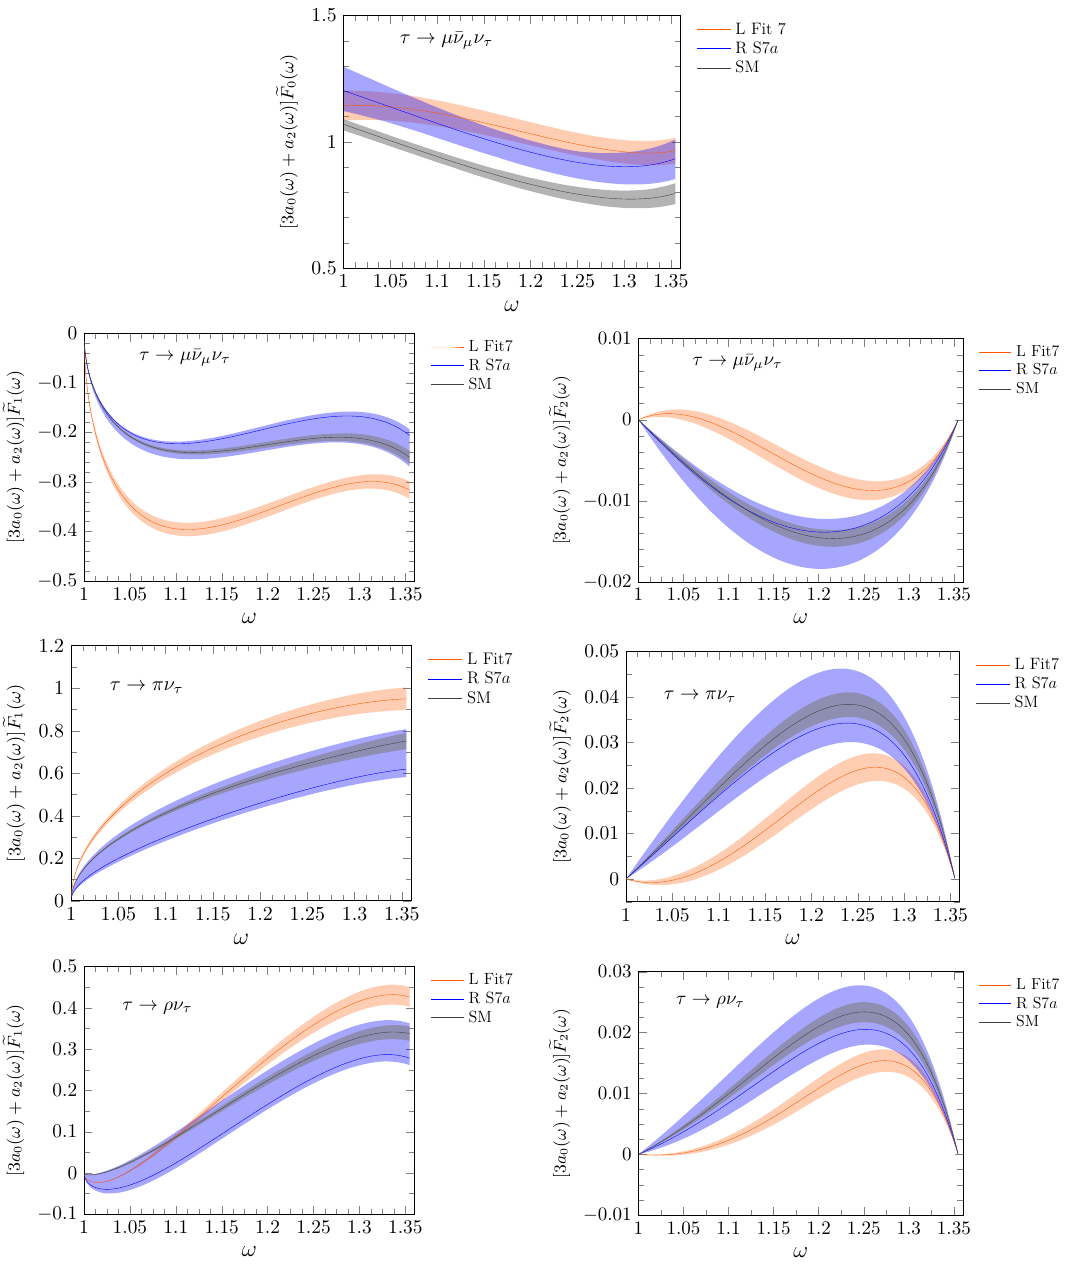
Figure 8 . Same as in figure 7, but for the ¯ B → D ∗ τ ( µ ¯ ν µ ν τ , πν τ , ρν τ )¯ ν τ